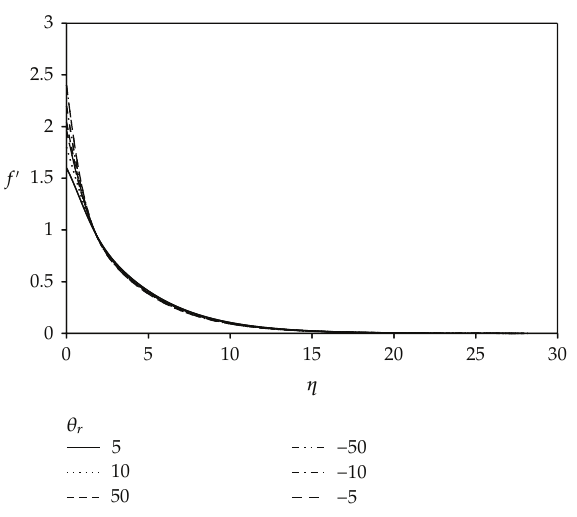
Figure 4: Velocity profile for di ff erent values of θ r for Du (cid:8) 0 . 03, Sr (cid:8) 2, N (cid:8) 1, Le (cid:8) 0 . 1, Pr (cid:8) 0 . 71, and Sc (cid:8) 0 . 1.